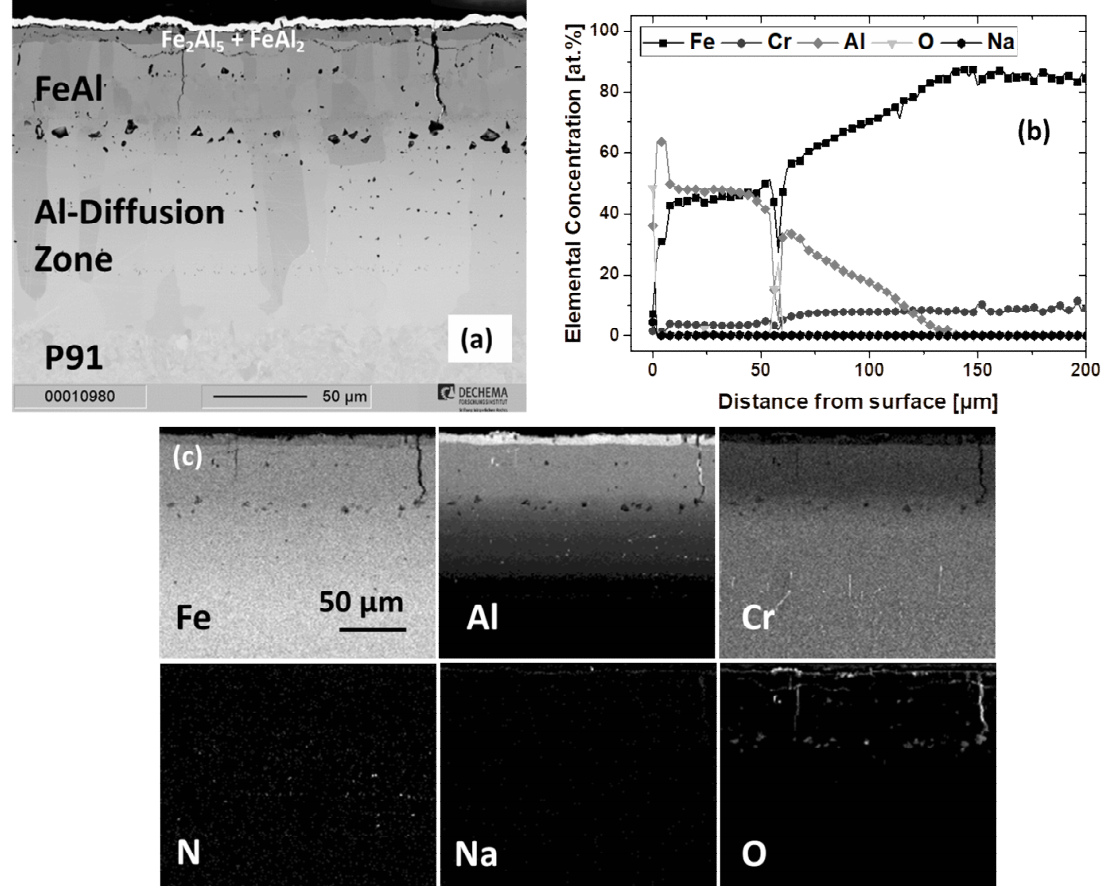
Figure 9. ( a ) Cross-sectional BSE-image, ( b ) quantitative line scans of Fe, Cr, Al, O and Na and ( c ) elemental distribution maps of aluminized P91 after 1000 h isothermal exposure in molten solar salt at 600 ◦